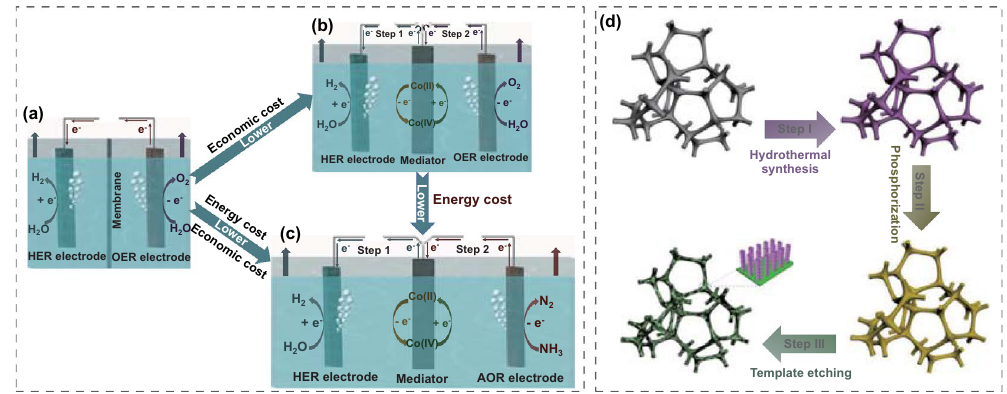
Fig. 1 H 2 production from different electrolytic cell architectures. a Conventional configuration of an alkaline water electrolysis cell with mem‑ brane. b Membrane‑free configuration for stepwise HER and OER in alkaline electrolyte. c Membrane‑free configuration for stepwise HER and ammonia oxidation reaction (AOR) in ammonia alkaline solutions. d Schematic illustration of the fabrication procedure of Co 2 P/CoP NAs elec‑ trocatalyst on